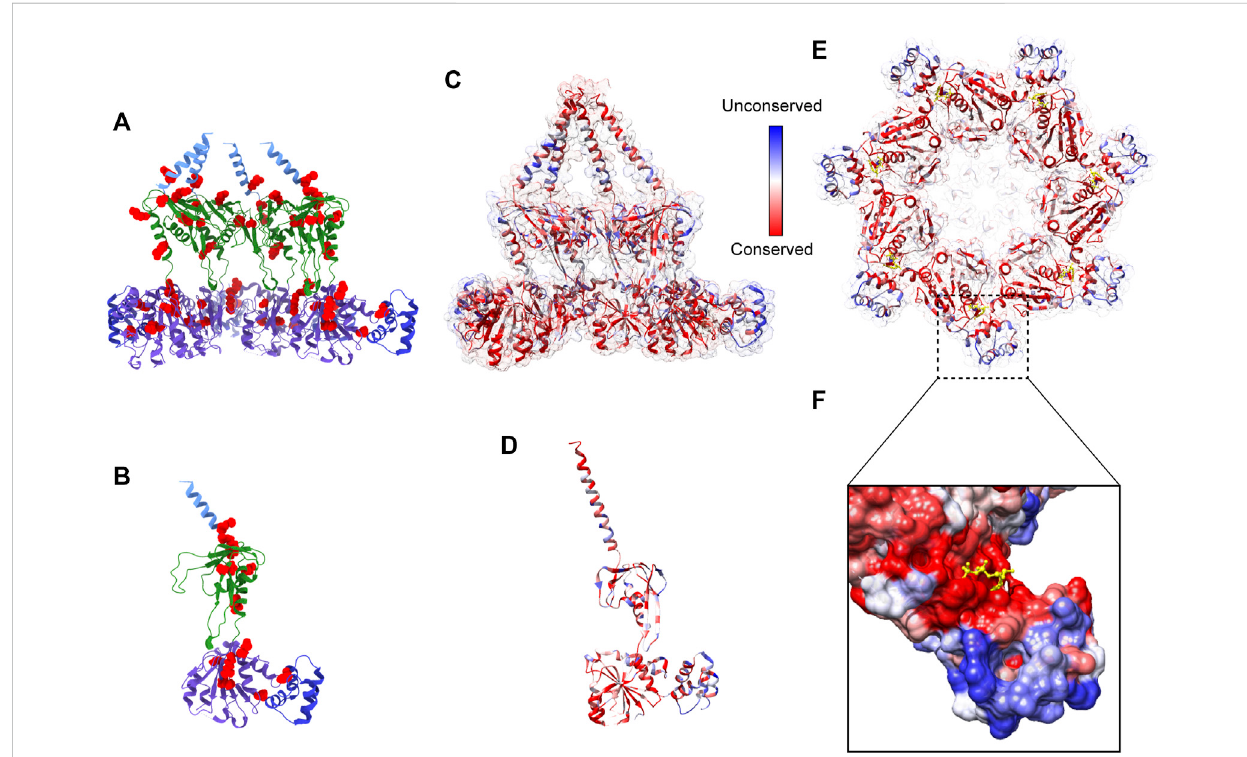
Pathogenic mutations on Bcs1 and potential target for fungicide design. (A, B) Pathogenic mutations of BCS1L are mapped onto the ribbon diagram ofmBcs1asredspheres.TheTMregion,Bcs1-speci fi cdomain,AAA-LDandAAA-SDofBcs1arecoloredincyan,green,purpleandblue,respectively.Cut side view is shown in (A) and Bcs1 protomer is shown in (B) . (C – E) Ribbon diagram of mBcs1 colored by sequence conservation, with most conserved residuescoloredinredandtheleastconservedresiduesinblue.ThecutsideviewandbottomviewofBcs1ringareshownin (C) and (E) respectively, and Bcs1 protomer is shown in (D) . (F) Zoom in view of an unconserved pocket in AAA-SD in the close vicinity of nucleotide binding pocket of Bcs1. The bound ADP is shown as yellow sticks. The surface of Bcs1 is also colored by sequence